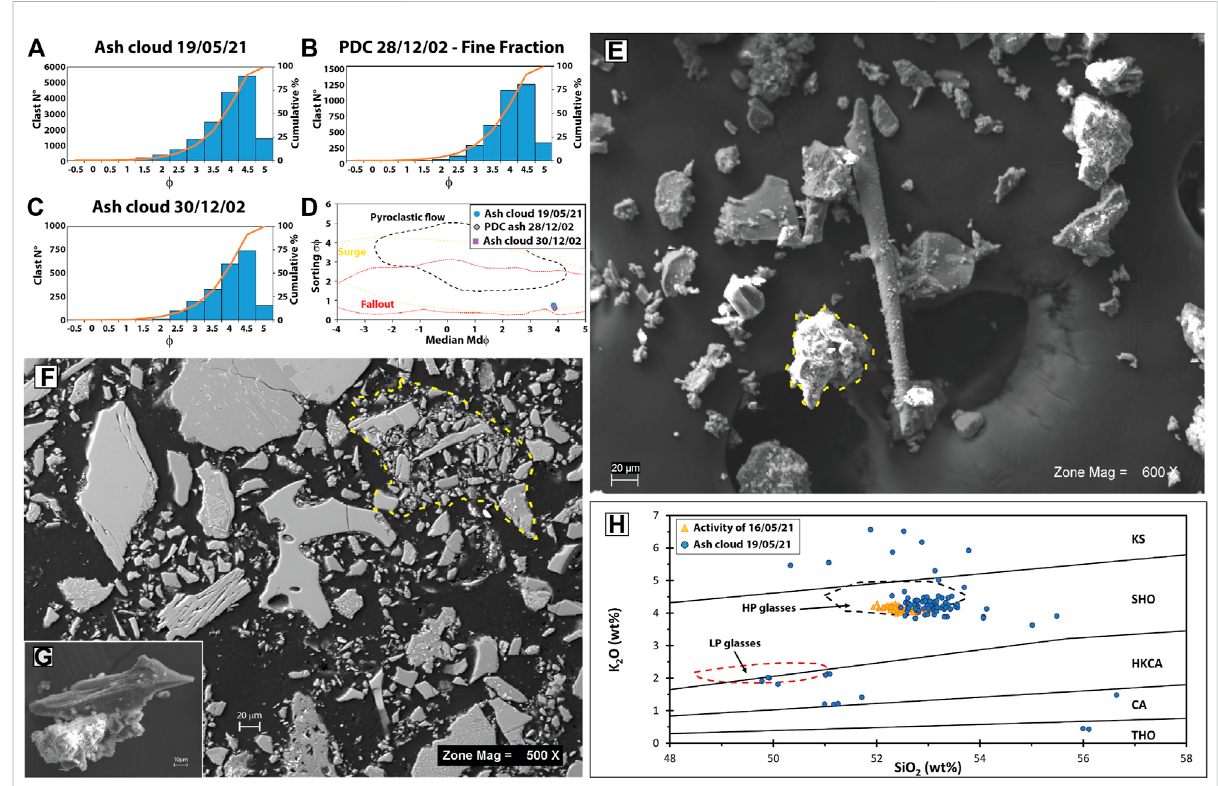
FIGURE 8 Grain size distributions of: (A) the ash cloud deposit emplaced after the 19 May 2021 PDC, (B) the ash elutriated from the pyroclastic density current of 28 December 2002; (C) the ash cloud emplaced from the Sciara del Fuoco collapse of 30 December 2002. (D) Median vs. Sorting plot (after Walker, 1971) distinguishes between deposits of pyroclastic fl ow, surge and fallout. SEM textures of 19 May 2021 ash: (E) 3D and 2D (F) views of the ash deposit, which mostly comprises lithic clasts and crystals, with scarse juvenile [in (E) with a peculiar elongated Pelee-hair shape); highlighted with yellow dashed lines are ash pellets, which occurr with NaCl crystal on its surface. (G) 3D close up of an ash pellet consisting of a glassy shard on which are attached fi ner ash particles; (H) SiO 2 vs. K 2 O plot of glass compositions (after Peccerillo and Taylor, 1976); THO, Tholeiitic series;CA,Calc-alkalineseries;HKCA,High-KCalc-alkalineseries;SHO,Shoshoniticseries;KS,Potassicseries.Bluecirclesrepresentglassyshardsin the ash cloud of 19 May 2021, red triangles are glassy groundmass in the lapilli produced by the persistent Strombolian activity on 16 May